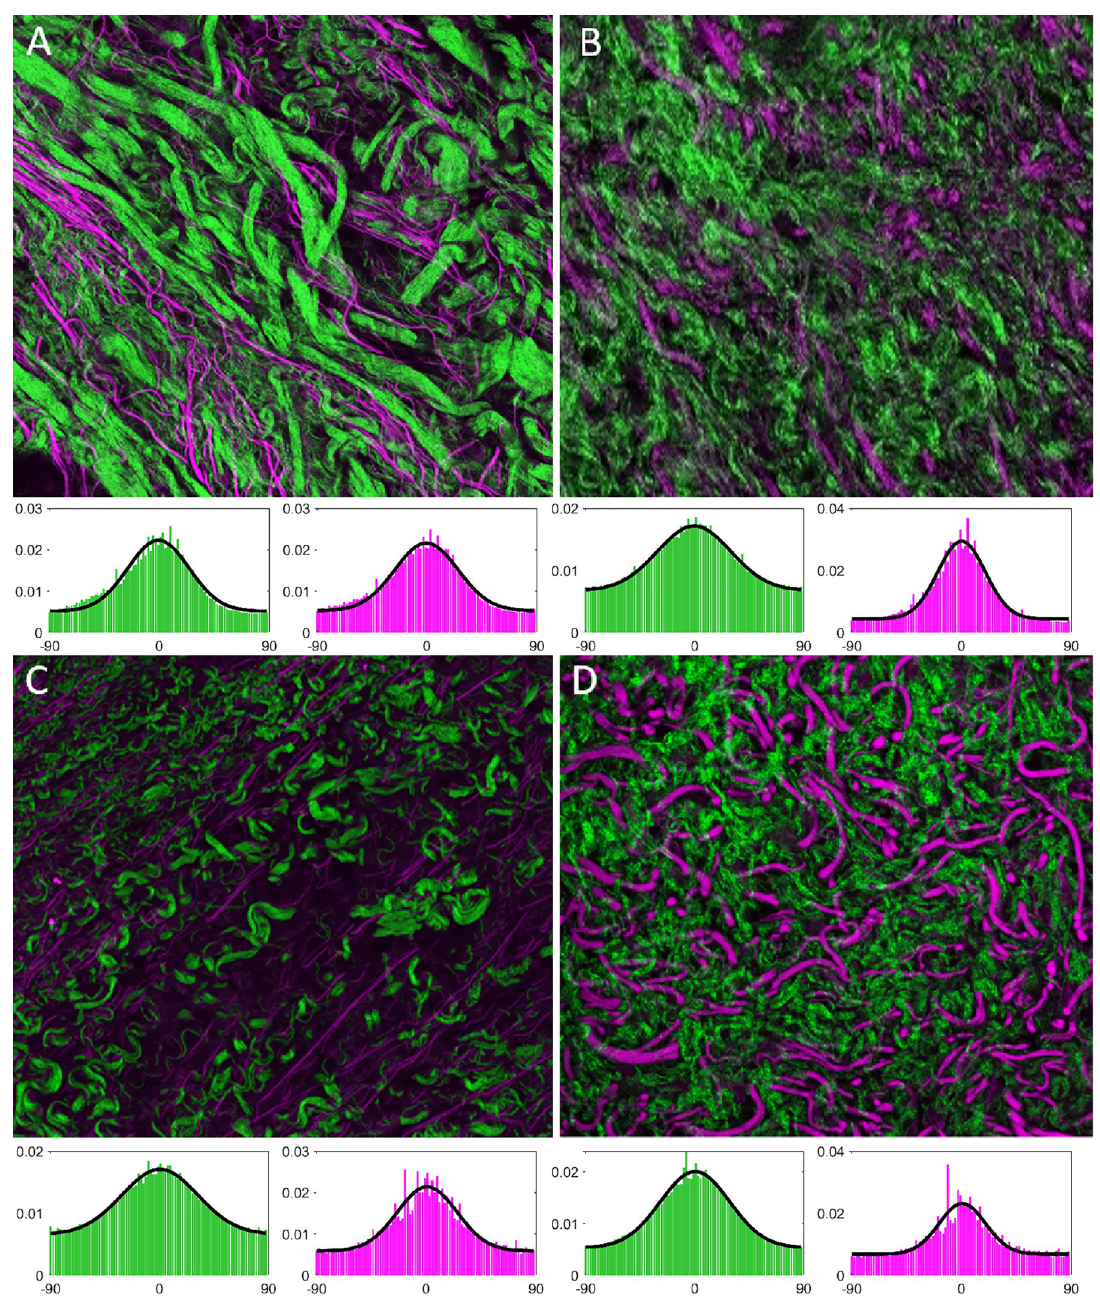
Fig 9. Nonlinear scanning laser microscopy of porcine vocal folds six months after surgery. Each image shows a single 40X field of view with collagen in green and elastic fibers in purple. Corresponding directionality distribution histograms and normal distribution fits for the entire lamina propria are shown below after centering the distributions at 0˚ (collagen in green and elastin in purple). A) Normal VF (unoperated, pig 4); B) hASC injection (pig 1); C) resected VF (scar, pig 2); D) COVR implant (pig